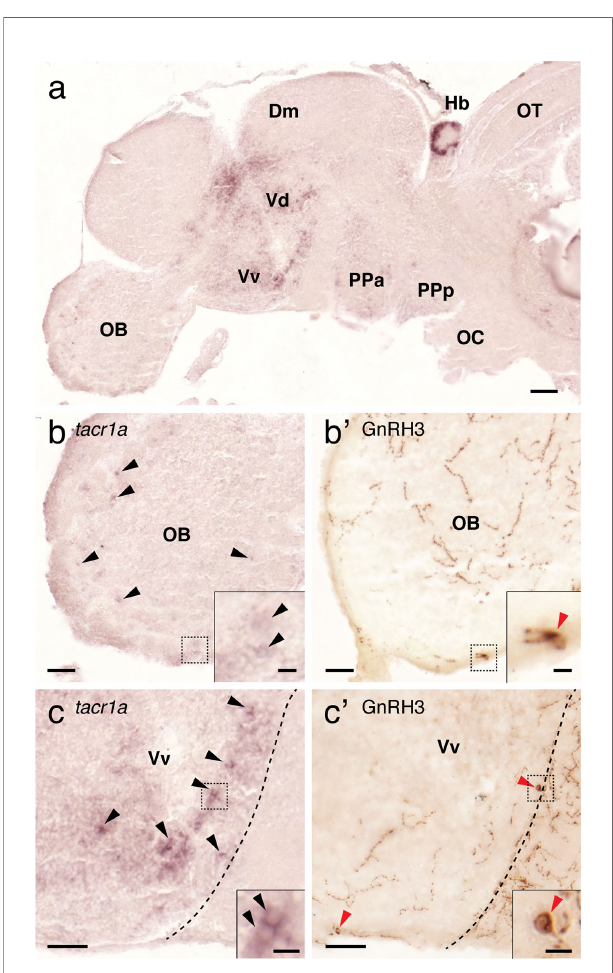
FIGURE 9 | Expression of tacr1a mRNA in the forebrain regions containing GnRH3 cells. In the forebrain, tacr1a mRNA is expressed in the olfactory bulb (OB), dorsal (Vd) and ventral (Vd) regions of the ventral telencephalon, and anterior part of the parvocellular preoptic nucleus (PPa) (A) . In the OB, weak expression of tacr1a mRNA was seen in the glomerular layer (b, black arrowheads), and in the primary olfactory fi ber layer of the olfactory bulb where GnRH3 neurons are present ( B ’ , red arrowheads). In the Vv, where another GnRH3 cell population is present ( C ’ , red arrowheads), tacr1a mRNA is broadly expressed ( C , black arrowheads). Doted box indicates the location of the inset. Scale bars: (A) , 100 µm; (B, B ’ , C, C ’ ) , 50 µm; insets, 10